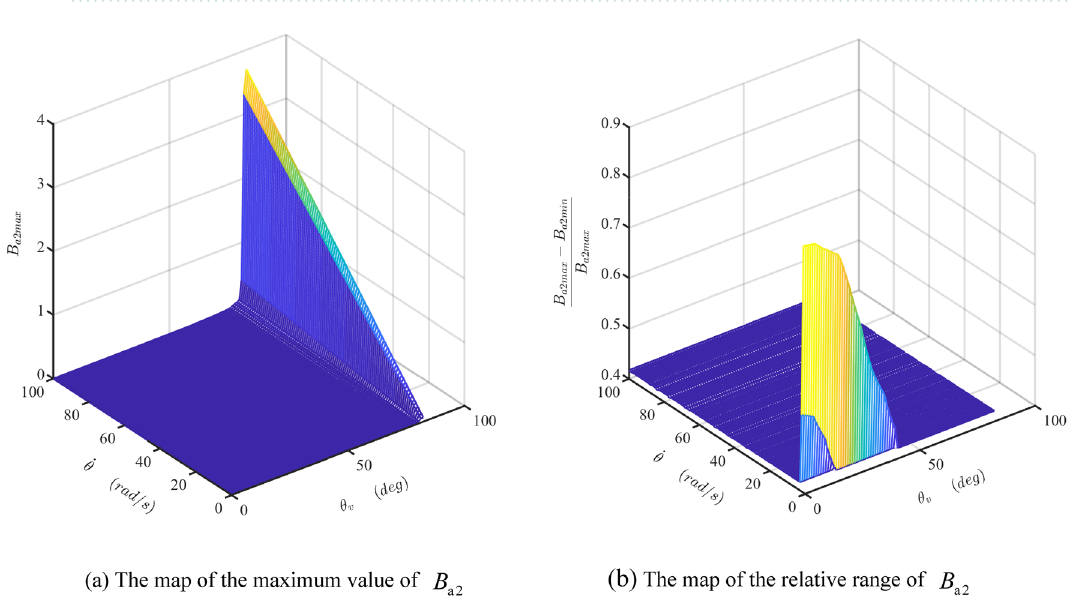
Figure 15. The maps of the maximum value and the relative range of the damper coefficient B a2 . (Matlab2019a. https:// ww2. mathw orks. cn/ produ cts/ get- matlab. html?s_ tid= gn_